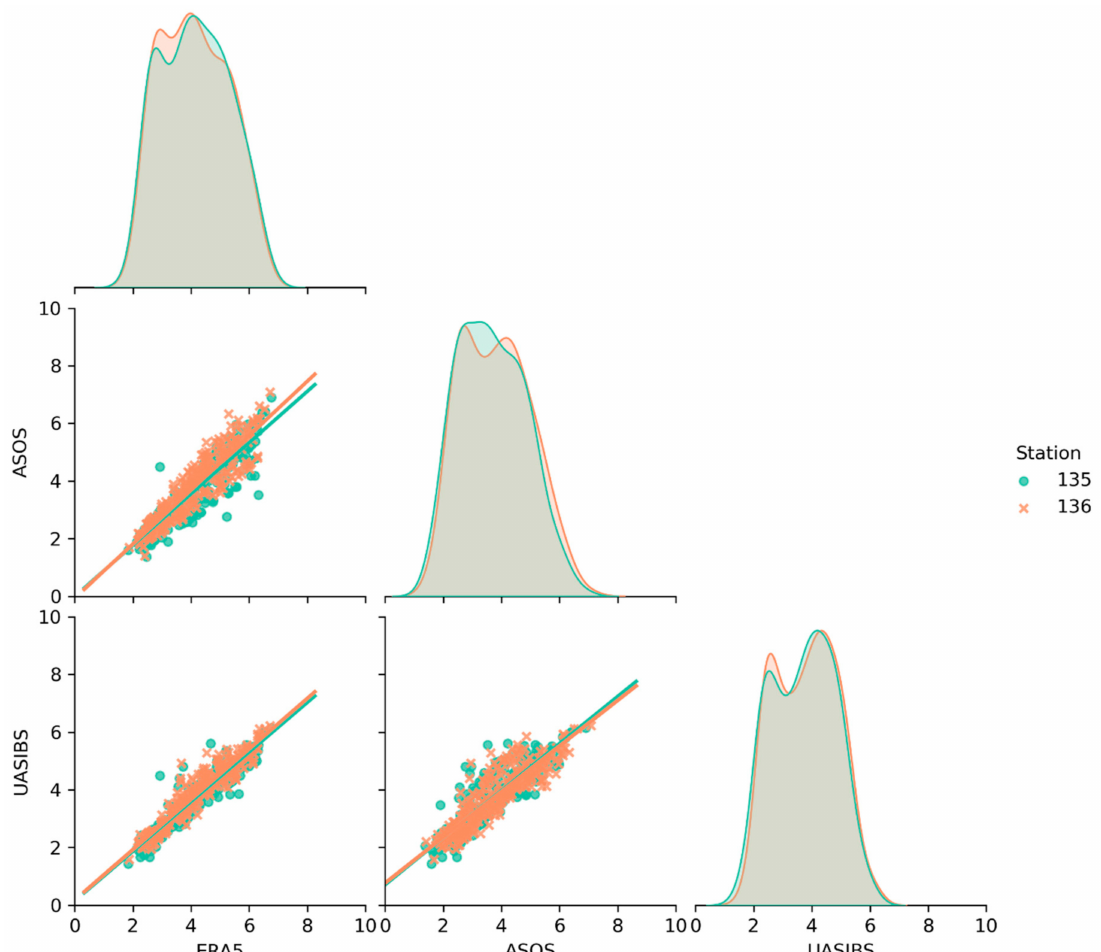
Figure 5. Correlation matrix of daily total irradiance averaged over each month from 1996 to 2019 between ground observation (ASOS), satellite estimates (UASIBS) and reanalysis (ERA-5). The green and orange colors indicate the dataset at 135 and 136 stations,